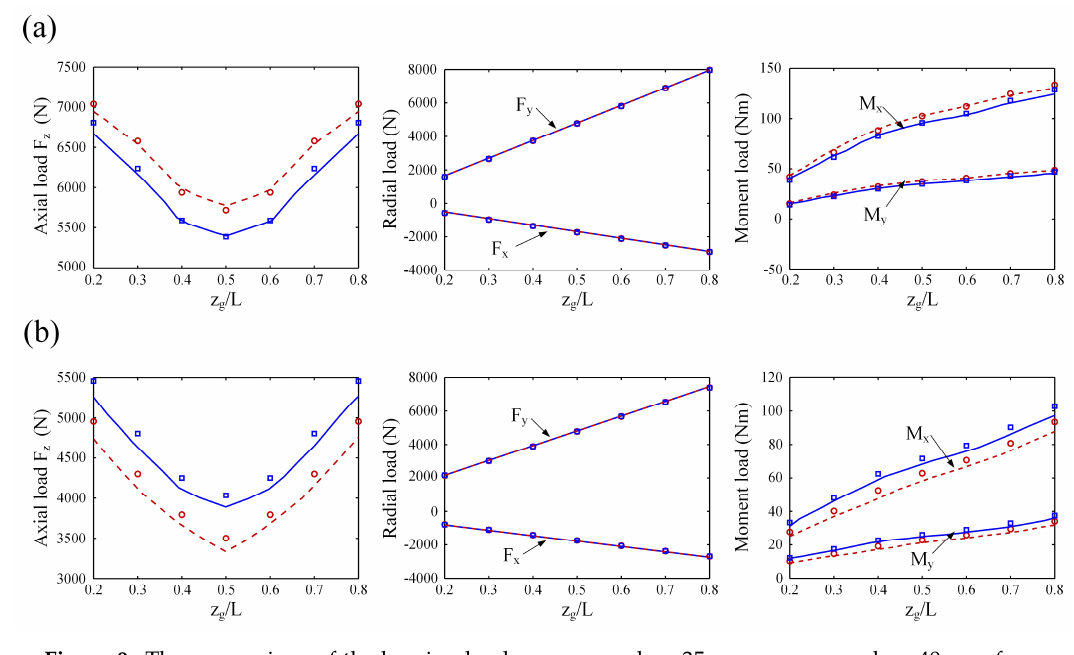
Figure 8. The comparison of the bearing angular displacements. ds = 35 mm, ds = 40 mm from Tong’s model and ds = 35 mm, ds = 40 mm from the present system model. ( a ) Face-to-Face arrangement; ( b ) Back-to-Back arrangement.